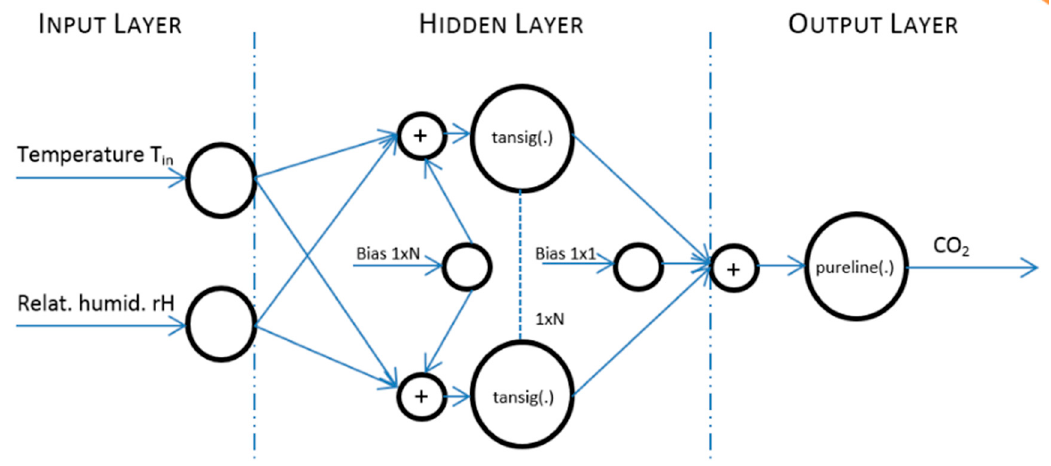
Figure 18. The architecture of the designed ANN SCG on test data measured in R203 from 25 June 2018 for two inputs T in and rH in without and FBG sensor for person presence measuring (PPM). Experiment 3.3a: Table 2. Learned ANN SCG from 25 June 2018 in R203 (with T in and rH in ) and prediction with cross- validation for 26 June 2018 in R203 (with T in and rH in ), 27 June 2018 in R203 (with T in and rH in ), 28 June 2018 in R203 (with T in and rH in ).